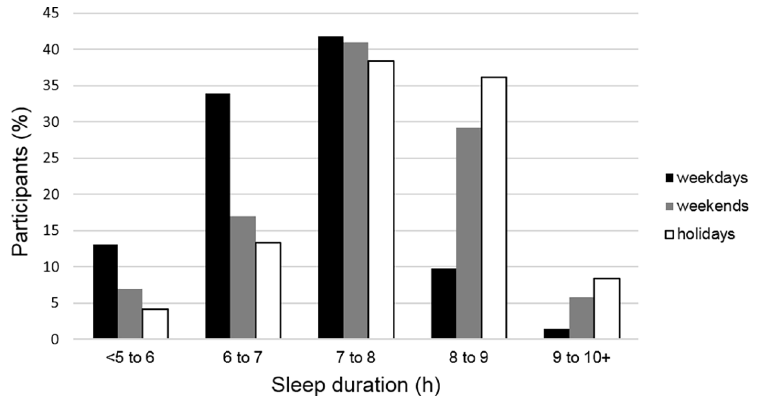
Fig 1. Habitual sleep patterns for weekdays, weekends and